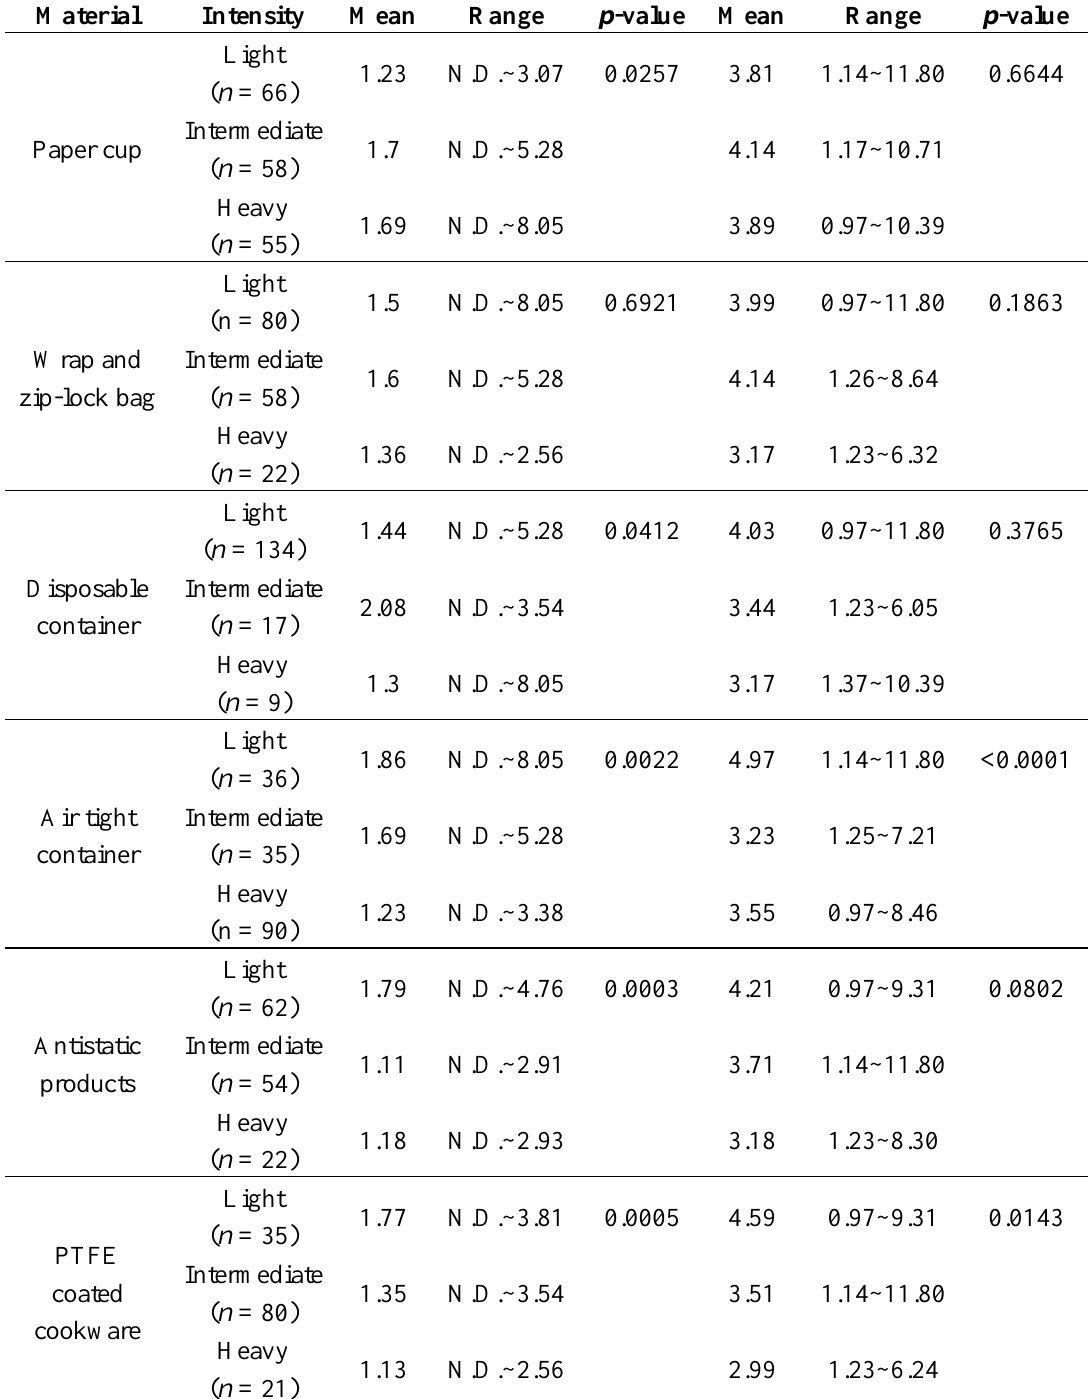
Table 2. The plasma levels of PFOA and PFOS and the multiple uses of food-contact commercial materials